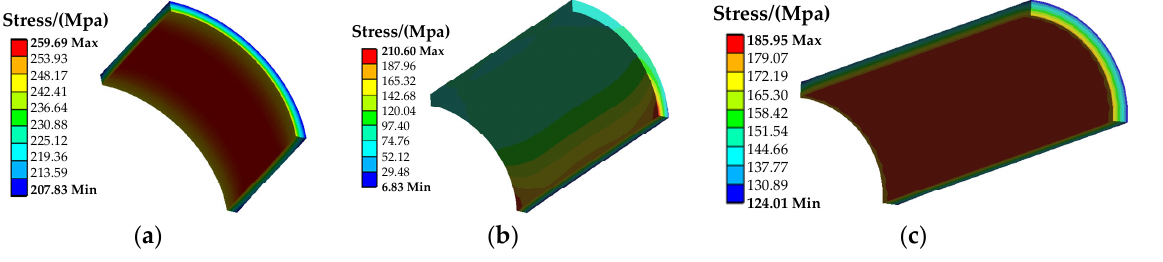
Figure 18. Sleeve Von-Mises stress distribution under the three cases at rated speed at a cold state: ( a ) Case 1; ( b ) Case 2; ( c ) Case 3.